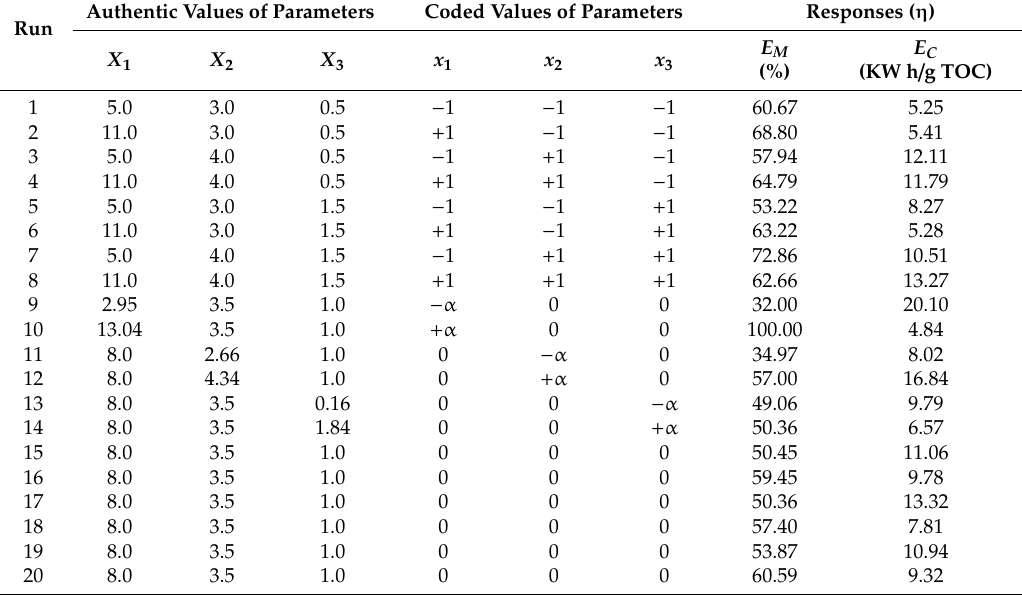
Table 4. CCR experimental design for electrochemical mineralization of